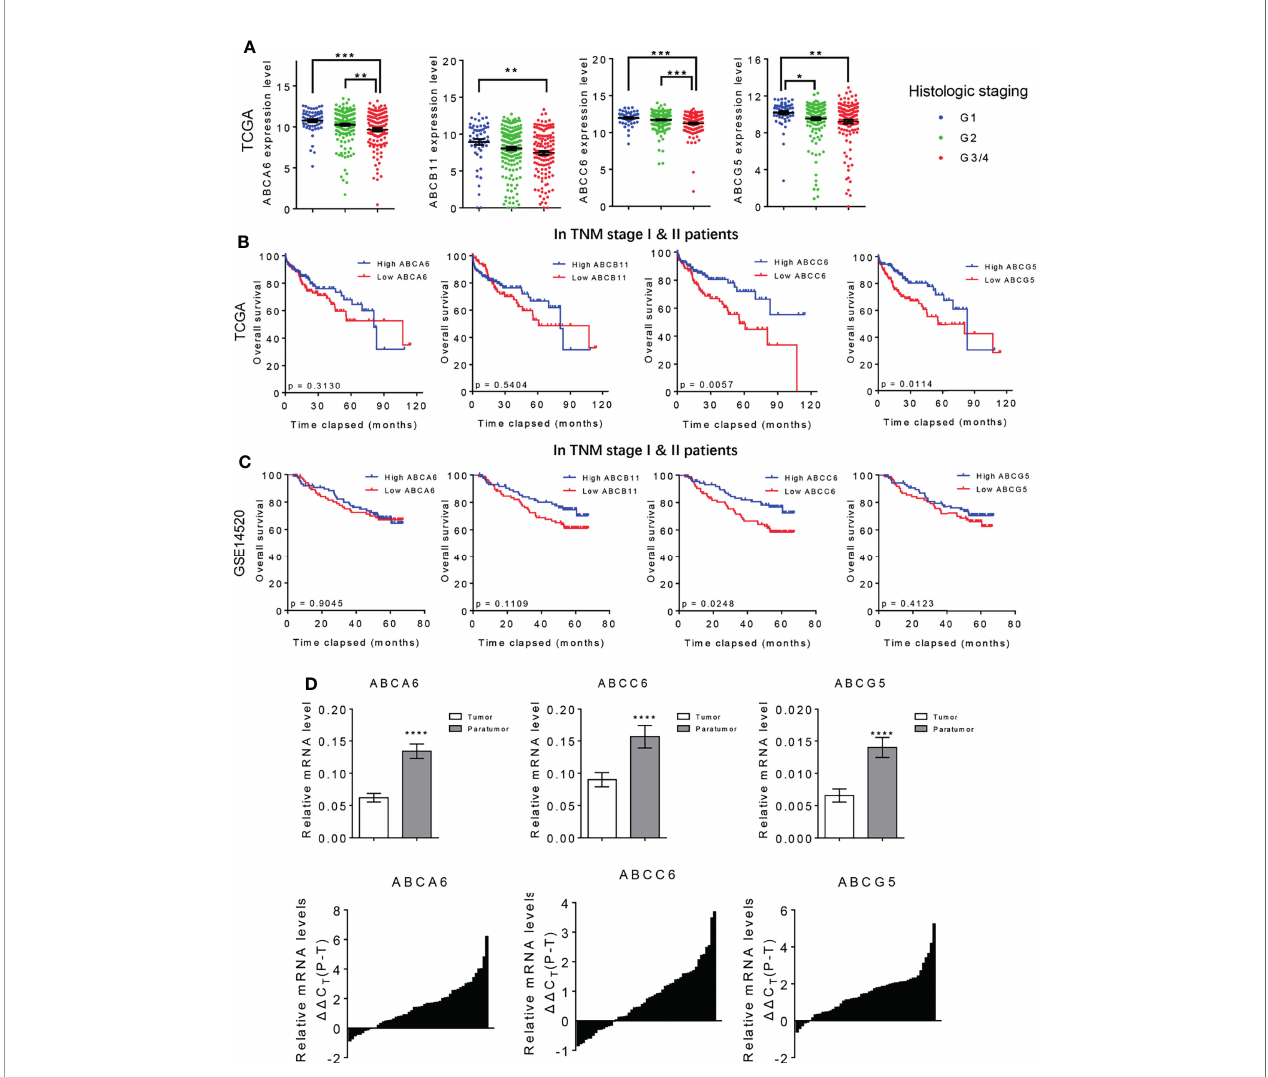
FIGURE 2 | ABCA6 , ABCC6 , and ABCG5 might serve as tumor suppressor genes in HCC. (A) TCGA database showing the expression level of ABC family genes in different HCC histologic staging. (B) Kaplan-Meier analysis showing the overall survival of early stage HCC patients (TNM I & II) with high or low ABC family genes level. Data was derived from TCGA database. (C) Kaplan-Meier analysis showing the overall survival of early stage HCC patients (TNM I & II) with high or low ABC family genes level. Data was derived from GSE14520 dataset. (D) qPCR analysis validating the differential expression of ABCA6 , ABCC6 and ABCG5 in 50 pairs of early-stage HCC tumor and paratumor tissues. Error bars indicate means ± SEM. P -values were determined by two tailed t -test (D) , one-way ANOVA (A) and Kaplan-Meier analysis (B, C) . * P < 0.05, ** P < 0.01, *** P < 0.001, **** P <